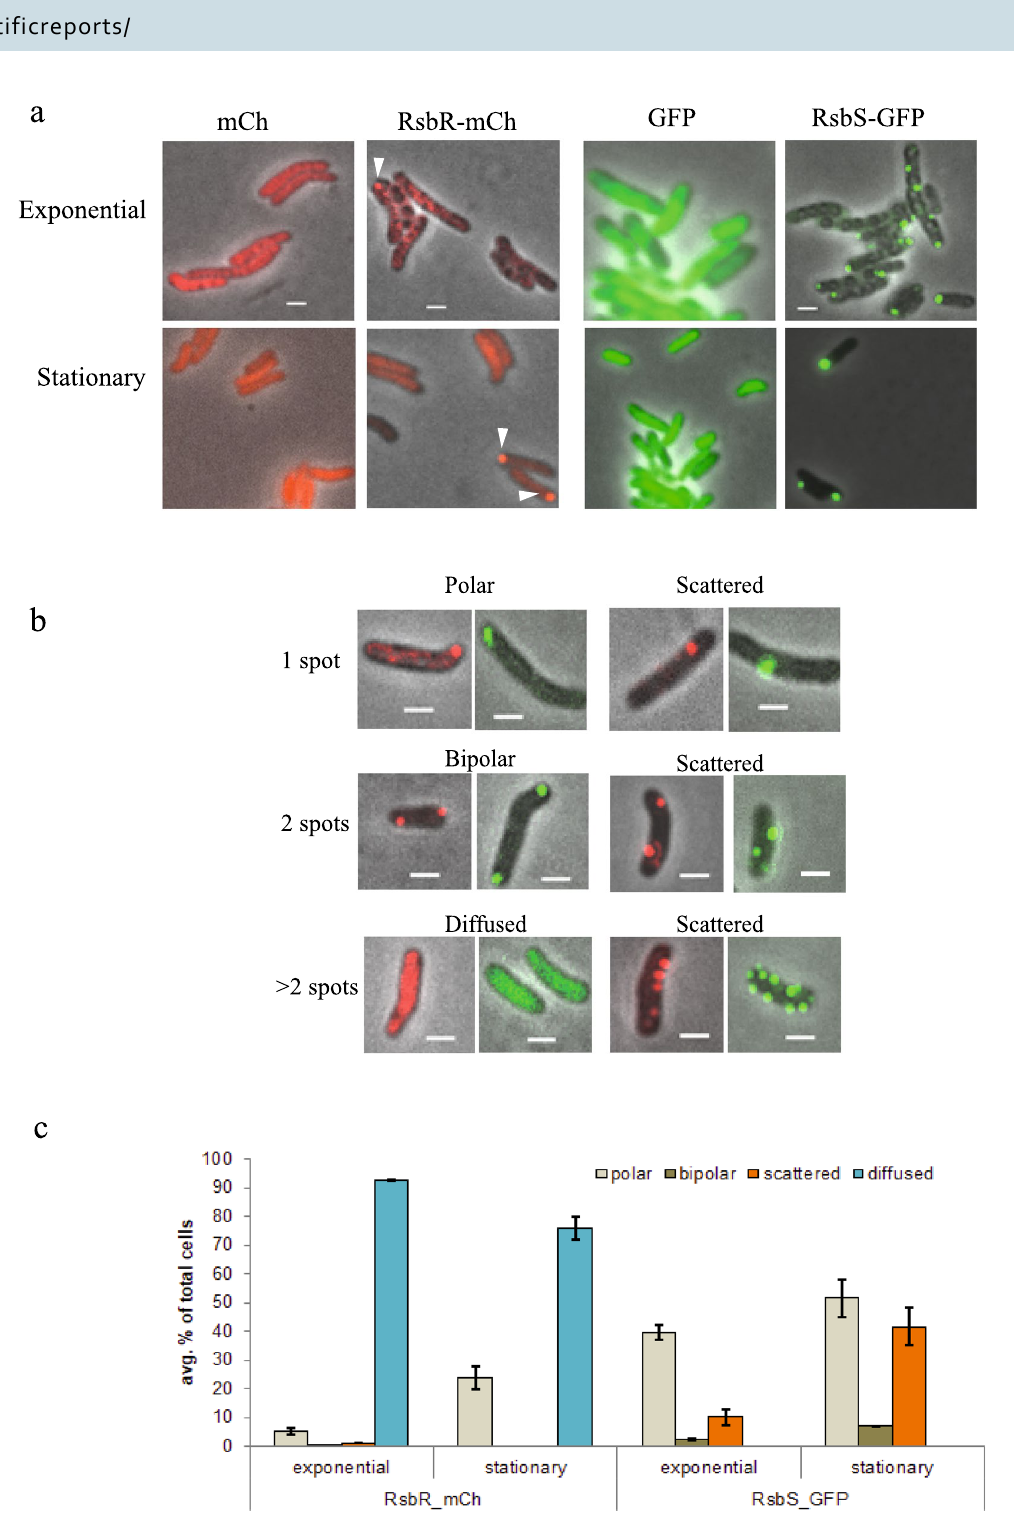
Figure 2. Localization of the "stressosome" subunits RsbR and RsbS in Mmar T detected by mCherry and GFP fusions. ( a ) Represents Mmar T strains carrying empty pBS401-mCherry (red) and pST2K-GFP (green) plasmids (first column to the left), the pBS401-RsbR-mCherry (red) and pST2K-RsbS-GFP (green) at exponential (2 days) and stationary phase (10 days) in second and third columns to the right. The foci of RsbR and RsbS localization is shown by white arrows, scale bar = 1 μm. ( b ) Represents the various classification of localization for statistics based on the position and number of spots (localizations) in a cell, scale bar = 1 μm. ( c ) Shows the average percentage distribution (with errors) of the different types of localizations of RsbR and RsbS in exponential and stationary growth phases with respect to total number of cells considered. As shown, most of the cells showed dispersed fluorescence with RsbR-mCherry in both exponential and stationary phase (blue bars). A total of two biological replicates were considered and minimum of 300 cells were counted for each time point/condition. The y-axis represents the average percentage of different "cell types" of total number of counted